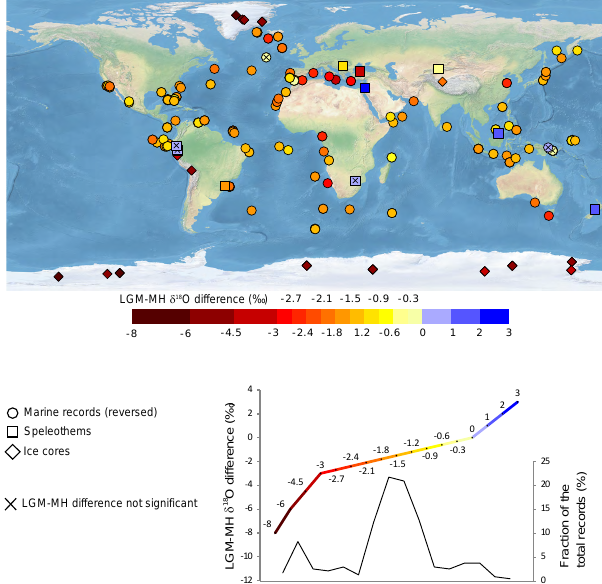
Figure 10. Same as Fig. 8 but between the MH and the LGM